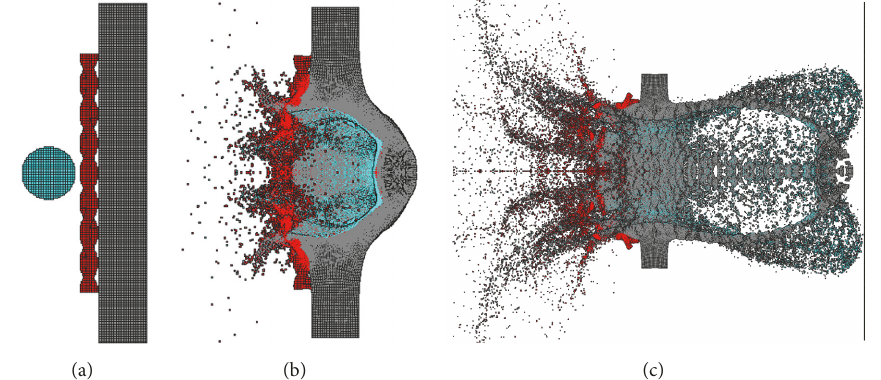
Figure 8: Impact of an aluminum projectile on a combined aluminum mesh-aluminum plate bumper (projectile aligned with crossover point): (a) 𝑡 = 0 ; (b) 𝑡 = 0.59 𝜇 s; (c) 𝑡 = 2.57 𝜇 s ∗ . ∗ Central fragment reaches the control section about 0.13 𝜇 s later ( ∼ 2.7 𝜇 s).